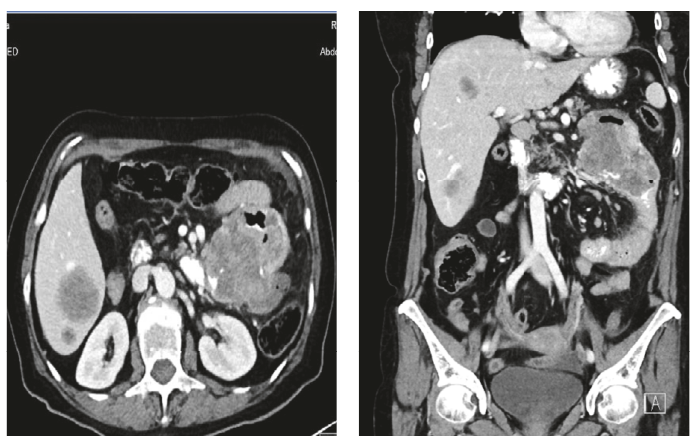
Figure 1: Axial and coronal CT scan showing a mass at proximal jejunum, with nearby free air and liver metastasis.